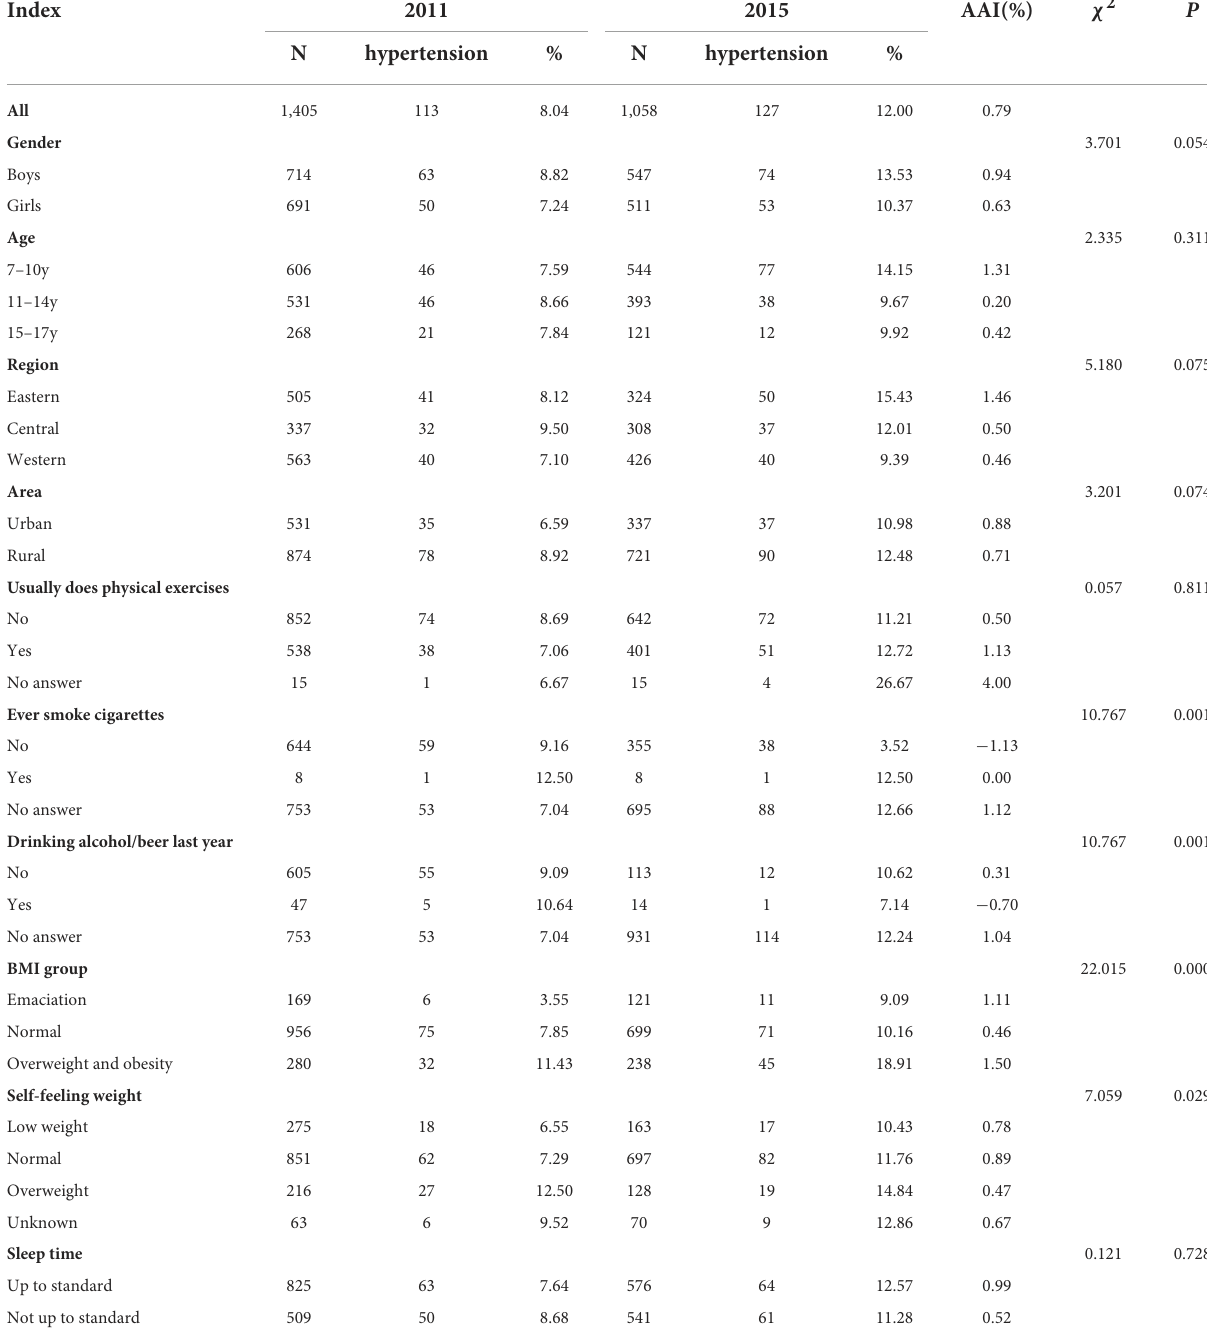
TABLE 3 Trends in the prevalence of hypertension among children and adolescents aged 7–17 years in China,